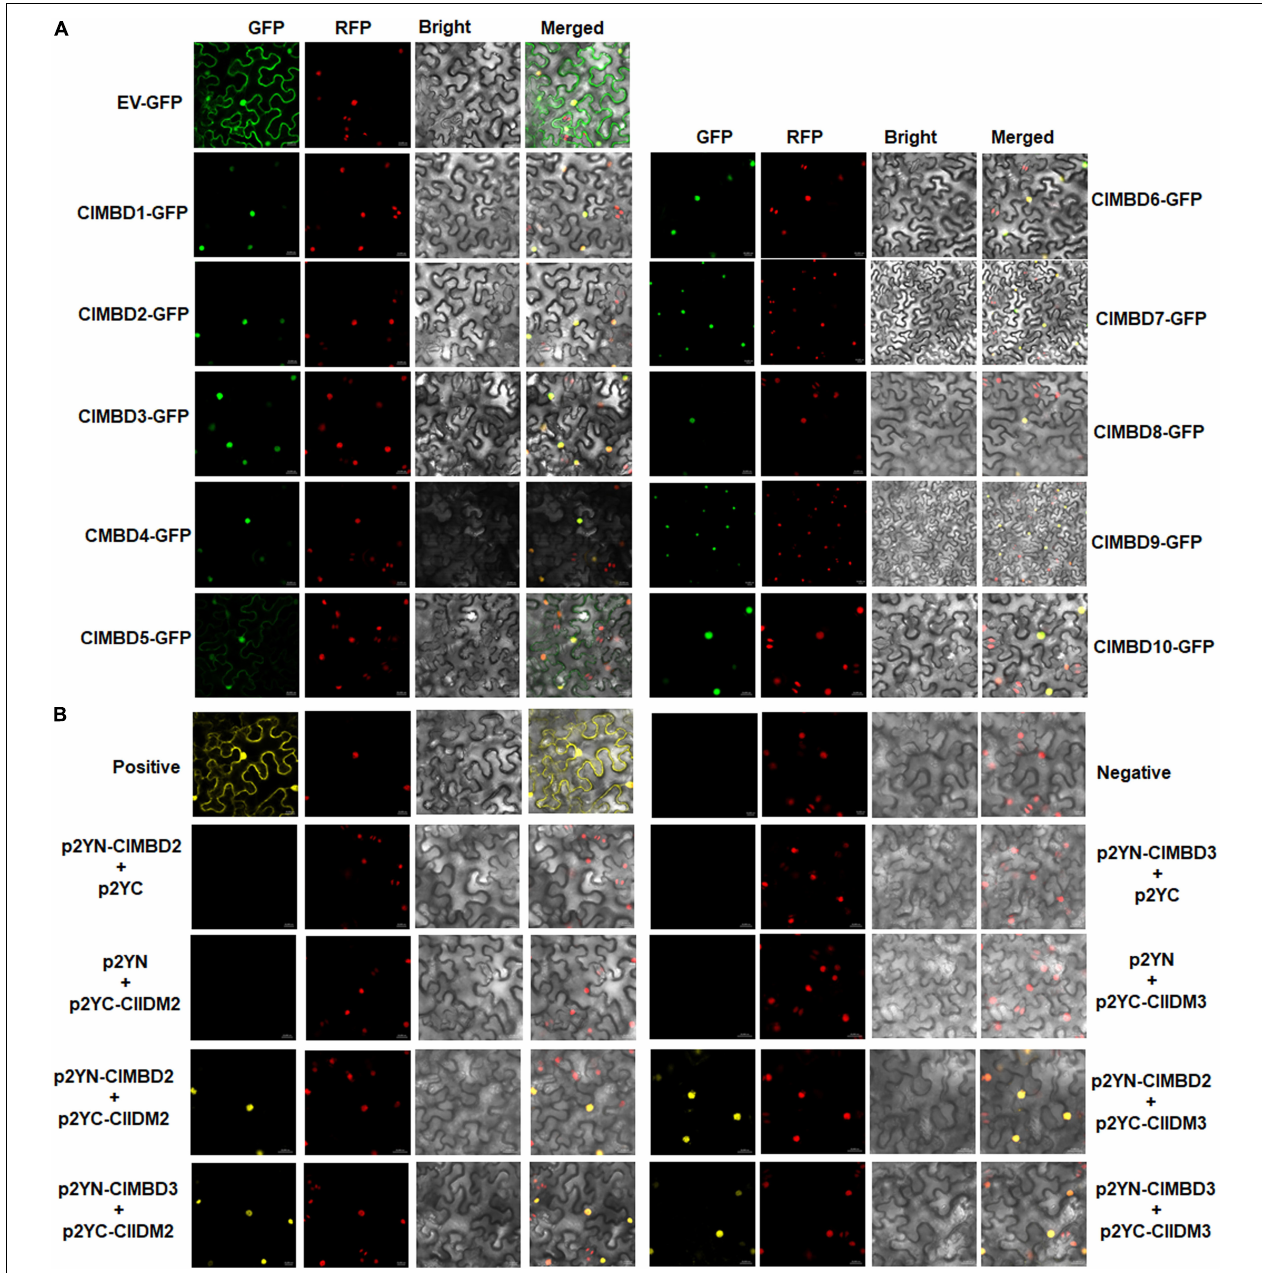
FIGURE 3 | Subcellular localization of the ClMBD proteins and the interactions between ClMBD2/3 and ClIDM2/3. (A) ClMBDs are nucleus-localized proteins. Agrobacteria carrying pCAMBIA1300-ClMBDs-GFP or pCAMBIA1300-GFP were infiltrated into leaves of N. benthamiana plants expressing a known nucleus-localized marker protein RFP-H2B. At 48 h after agroinfiltration, GFP signals were visualized under a confocal laser scanning microscope in dark field for green fluorescence ( left ), red fluorescence ( middle left ), white field for cell morphology ( middle right ) and in combination ( right ), respectively. (B) Interactions of ClMBD2 and ClMBD3 with ClIDM2 and ClIDM3. Agrobacteria carrying indicated pairs of p2YC and p2YN plasmids were infiltrated into leaves of N. benthamiana plants expressing a red nuclear marker RFP-H2B protein, and YFP and RFP signals were observed at 48 h after infiltration. Images were taken in dark field for green fluorescence ( left ) and red fluorescence ( middle right ), white field for cell morphology ( middle left ) and in combination ( right ), respectively. Experiments in (A,B) were repeated for three times with similar results.